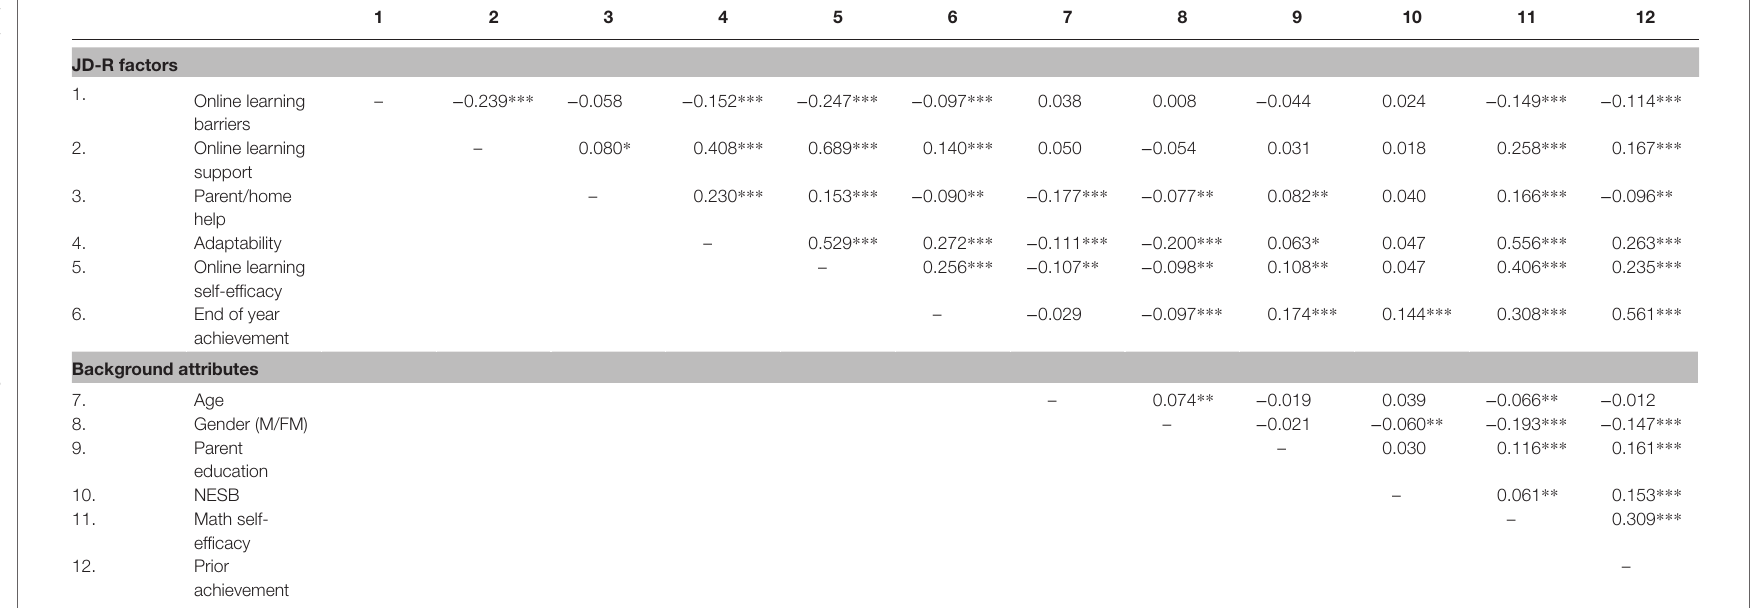
TABLE 2 | Correlations from